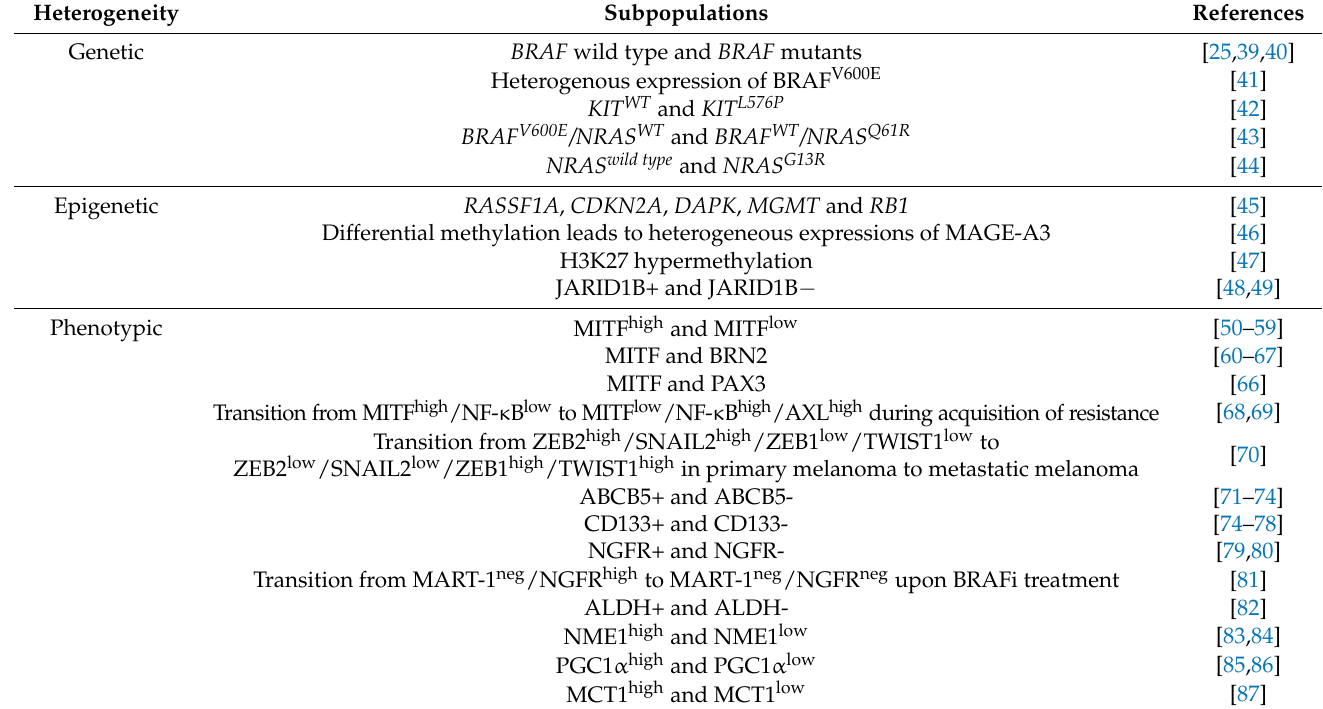
Table 1. Summary of three different aspects contributing to intratumoural